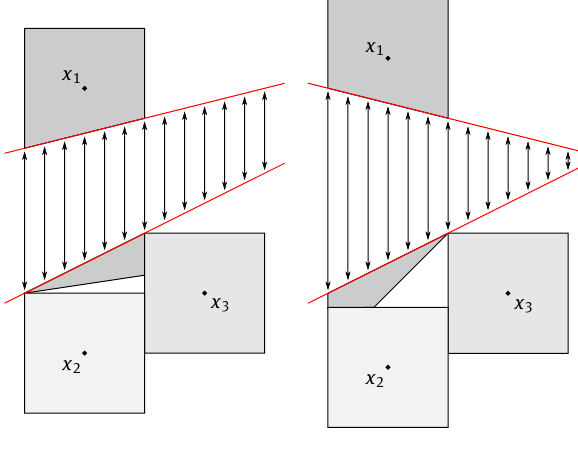
Figure 1: Gluing halfspaces in l 2 ∞